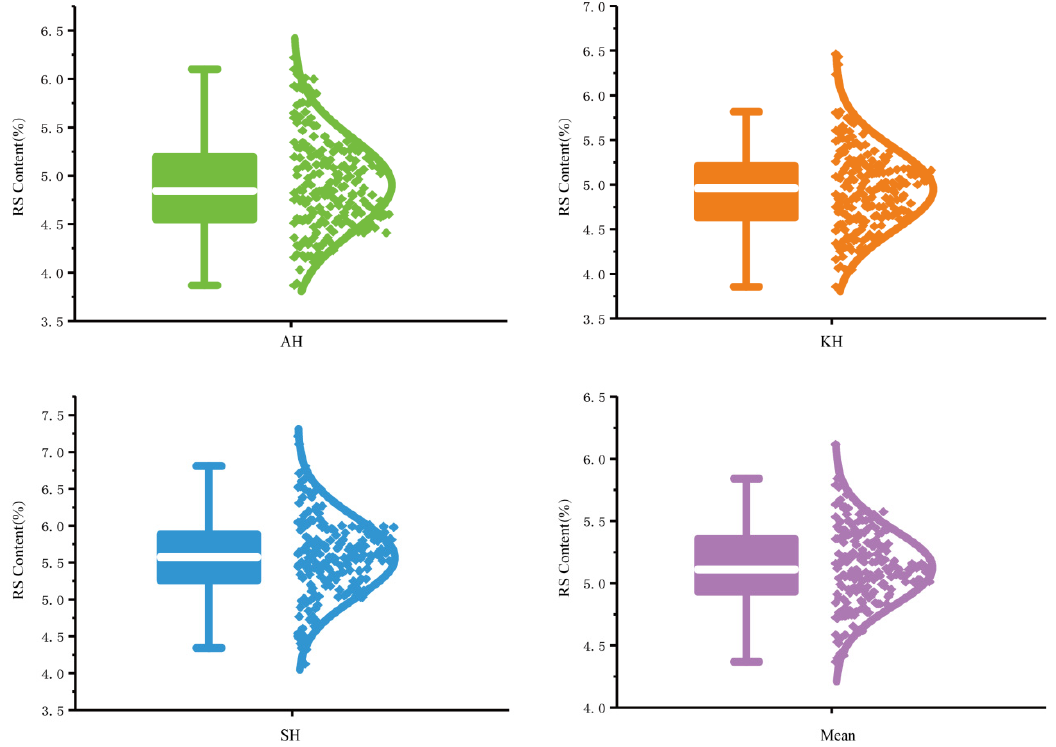
Figure 1. Phenotypic distribution of the RS content in the association population and the average RS content under three locations. The locations where the association population planted were labeled under the x -axis, while the RS content was displayed in the y -axis. The dots with different colors represent the value of RS content of each variety in the association population. Different color represent RS content investigated from different locations. Table 1. Genetic loci for RS content in the association population under three locations identified through